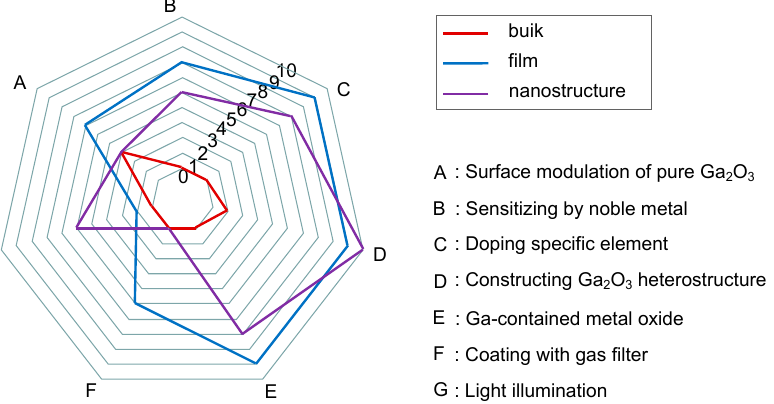
Figure 20. Radar chart of seven performance enhancement strategies of gas sensors made by Ga 2 O 3 bulk crystal, thin films, and nanostructures. Original drawing was done by us. (i)